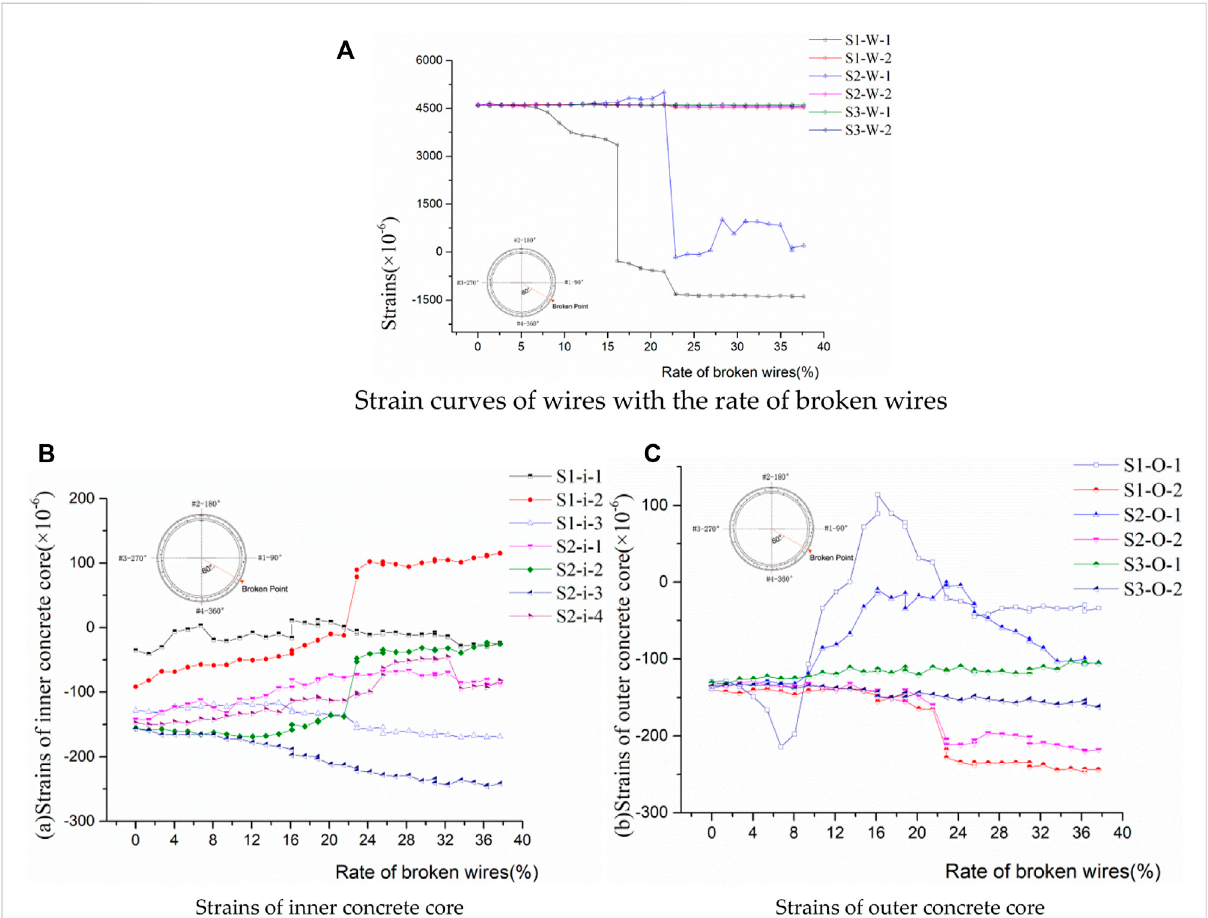
FIGURE 13 Straincurvesofwireswiththerateofbrokenwires. (A) Straincurvesofwireswiththerateofbrokenwires, (B) strainsoftheinnerconcretecore, and (C) strains of the outer concrete